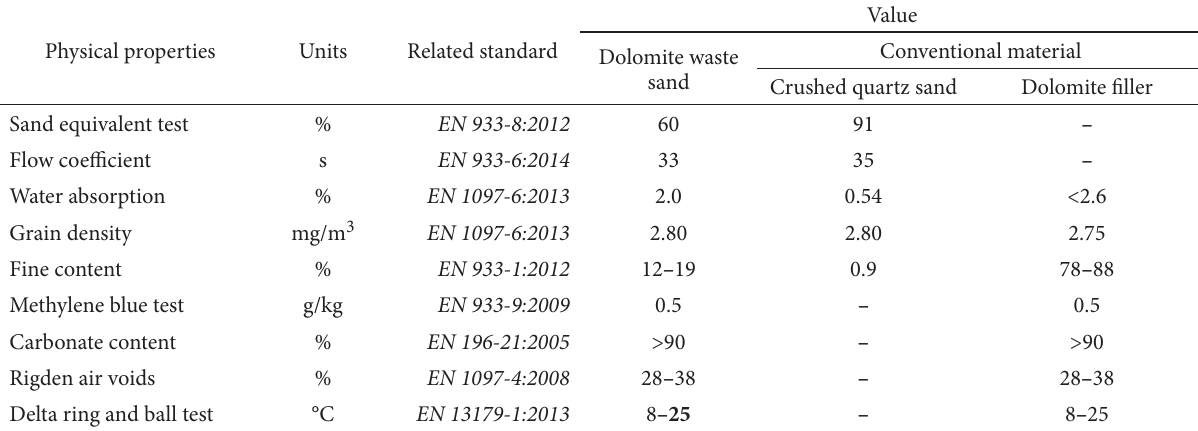
table 2. Physical characteristics of dolomite